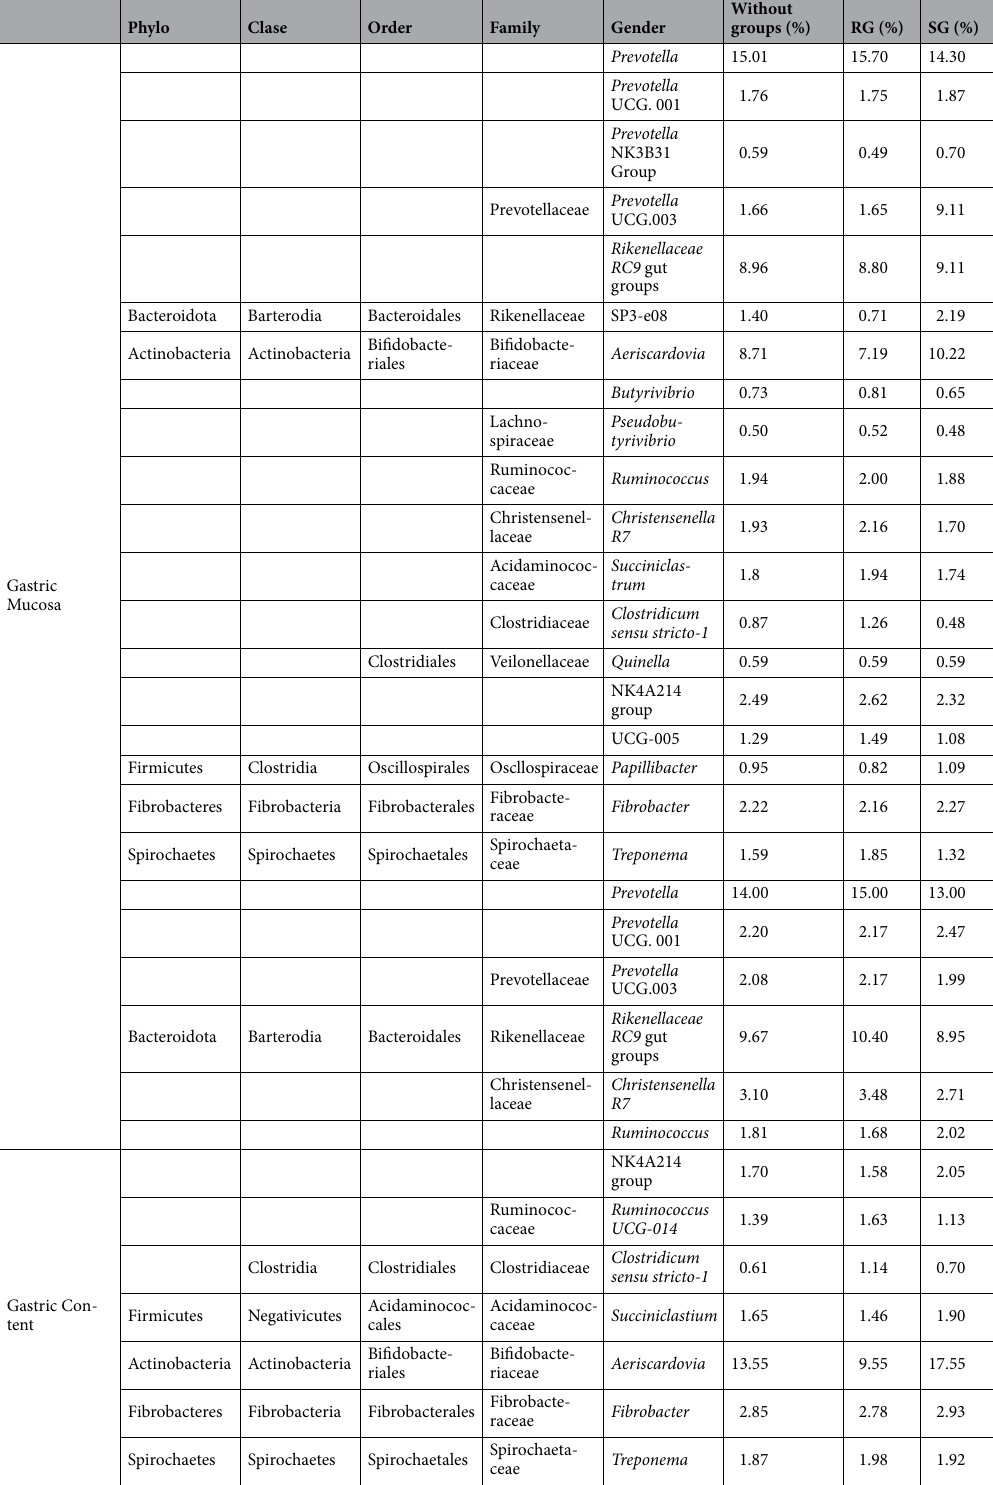
Table 1. Principal taxa in gastric mucosa and gastric content samples between RG and SG in T. circumcincta